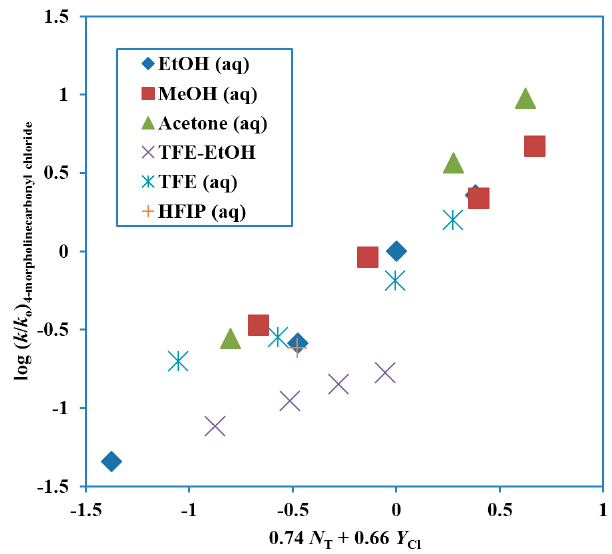
Figure 3. Plot of log ( k / k o ) for solvolyses of 4-morpholinecarbonyl chloride (4-(chloroformyl)morpholine) at 25.0 °C against 0.74 N T + 0.66 Y Cl .